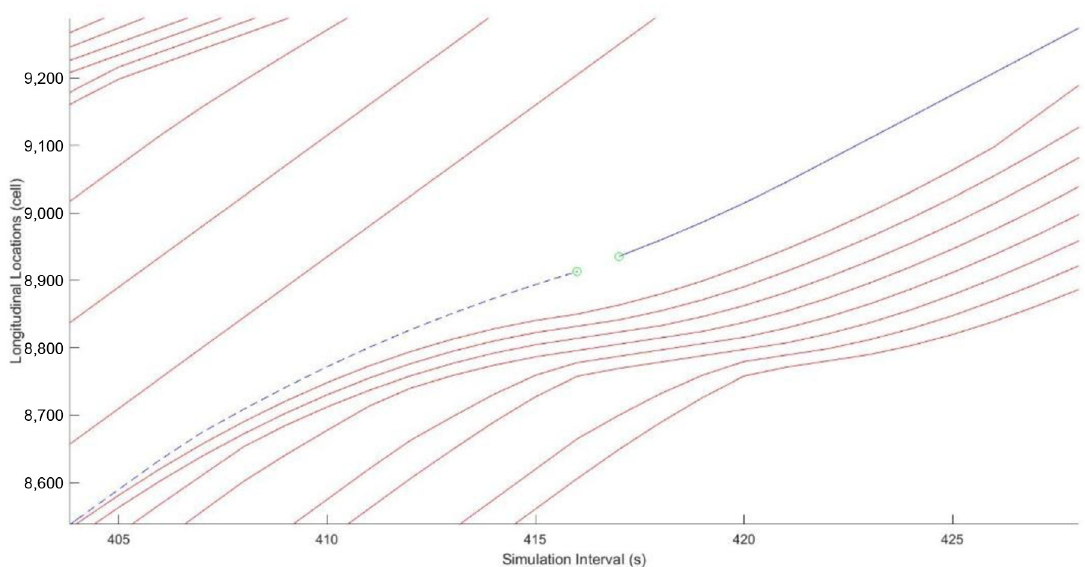
Figure 6 Cooperation between CAVs and MVs during lane-changing period